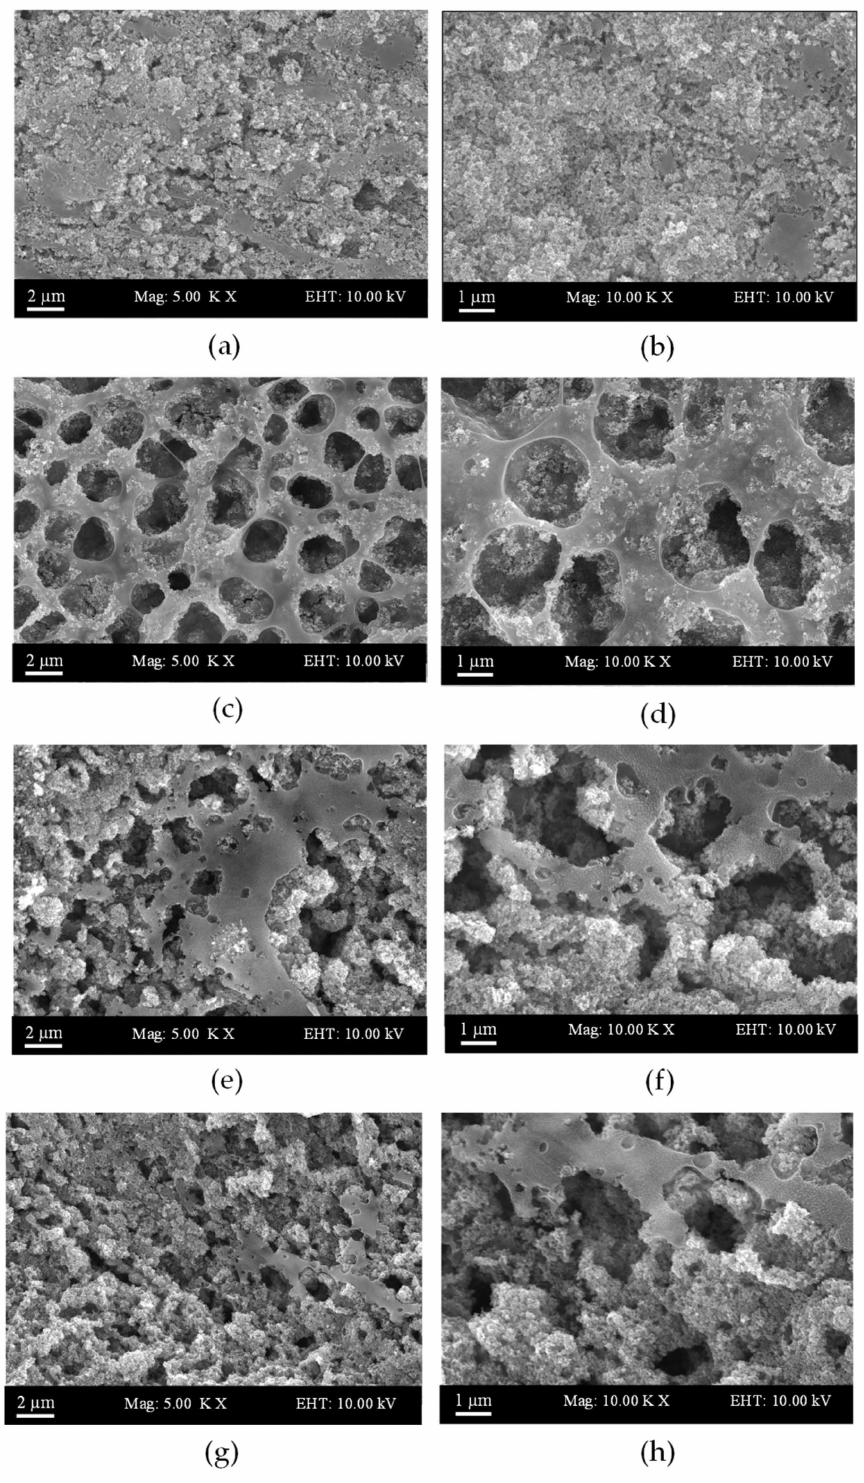
Figure 1. Field emission scanning electron microscopy (FESEM) of ( a , b ) TEP0, ( c , d ) TEP12, ( e , f ) TEP24 and ( g , h ) TEP30 under 5000 × and 10,000 × magnification,